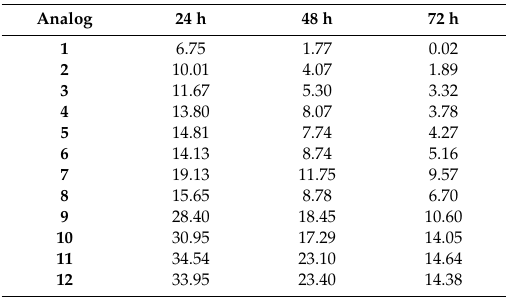
Table 3. IC 50 Values ( µ M) for N -alkyl-acridone and N , N (cid:48) -dialkyl-9,9-biacridylidene analogs treated with MCF-7 breast cancer cells for 24, 48, and 72 h incubation. As no total inhibition was observed for some derivatives the corresponding values could be given as relative IC 50 .